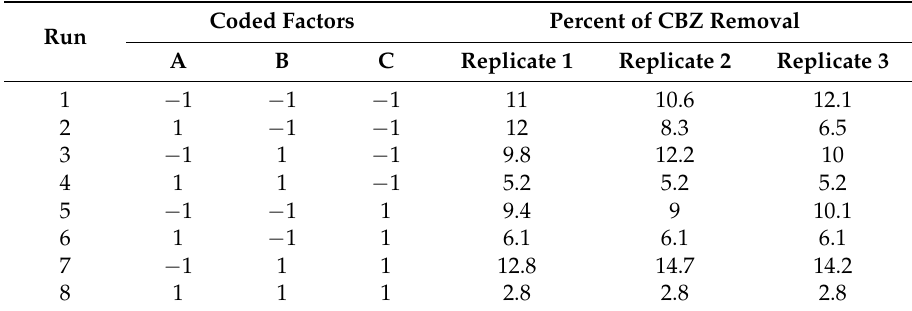
Table 3. CBZ adsorption experiments. A, particle size; B, temperature; C, pH. Factor levels, low ( − 1), high (+1).